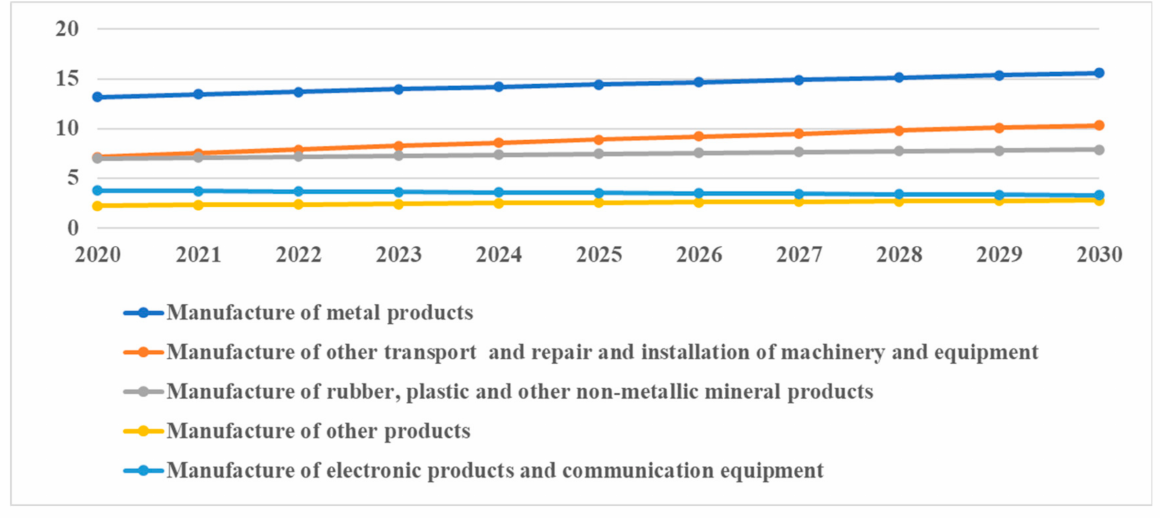
Figure 15. Net profitability till 2030, % (own